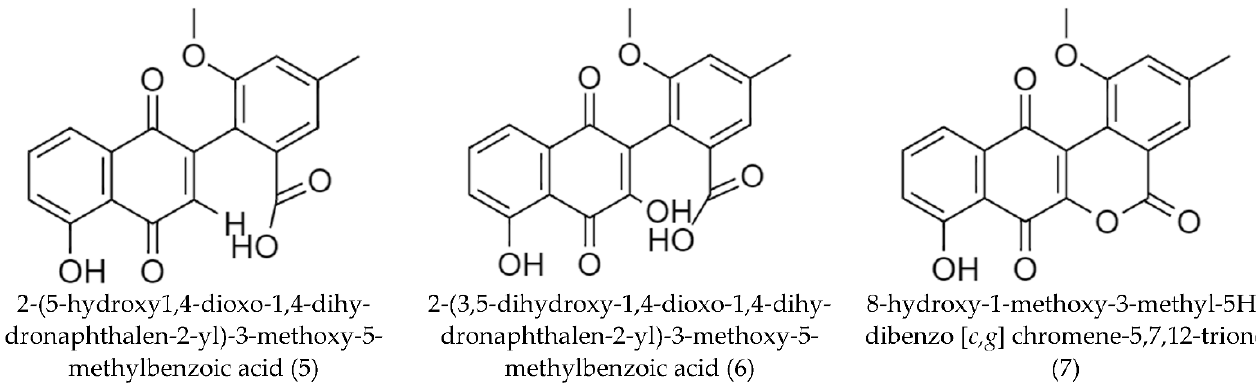
Figure 7. Chemical structures of naphthoquinones.